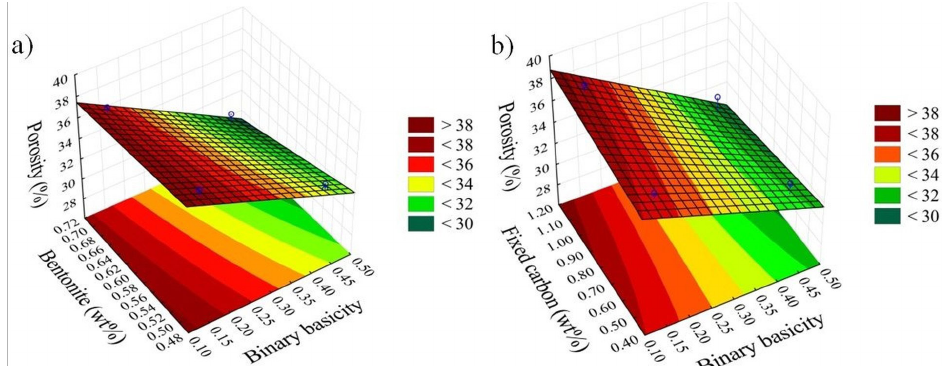
Figure 9. Response surface plot. a) Relation between porosity against bentonite and binary basicity. b) Relation between porosity against fixed carbon and binary basicity.